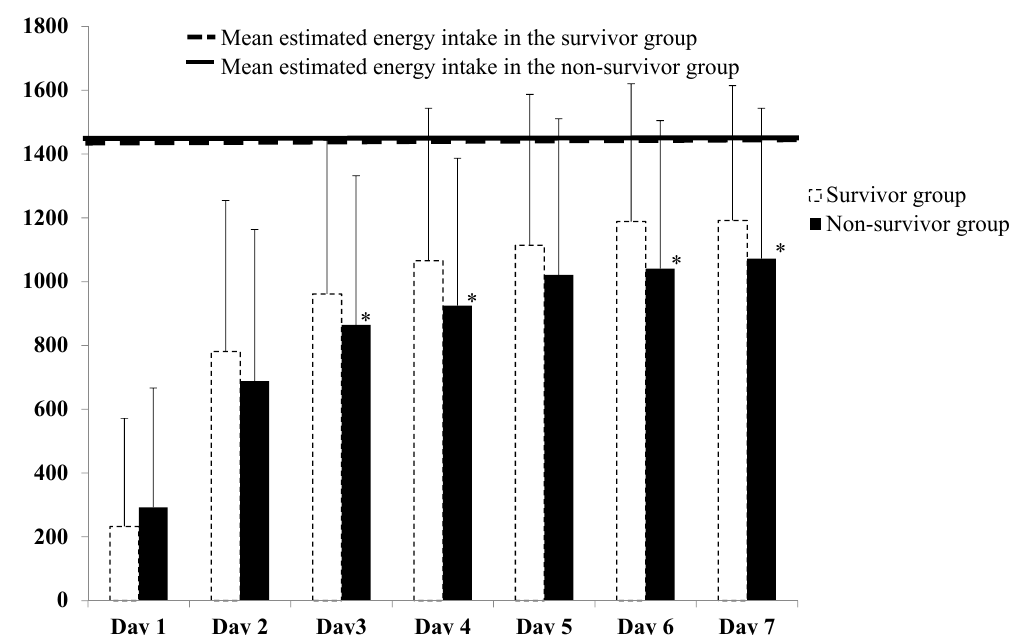
Figure 2. Mean estimated energy intake and actual energy intake in the survivor and non ‐ survivor group from day 1 to day 7. * Values are significantly different between the survivor and non ‐ survivor groups; p < 0.05.